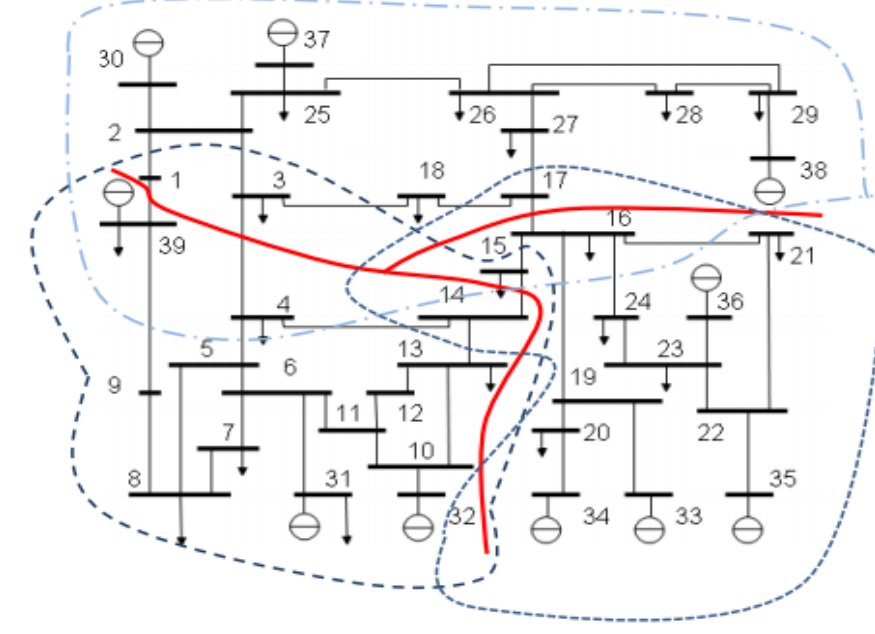
Figure 4. Decomposition of IEEE 39-bus System.